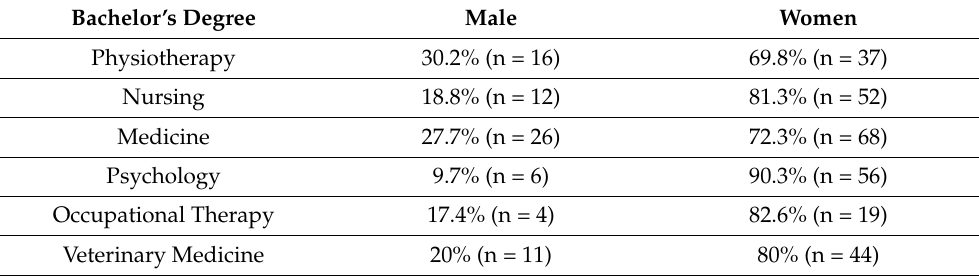
Table 1. Characteristics of the sample according to the field of study.